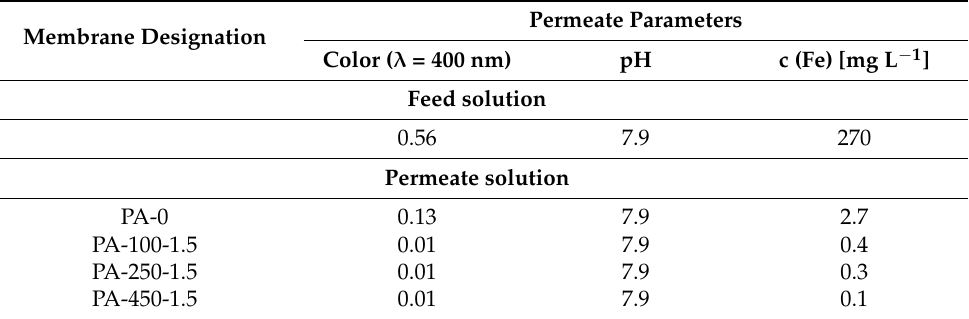
Figure 10. Dependence of 0.005 wt.% HAs solution flux ( a ), fouling recovery ratio (FRR, %) and total flux decline ratio (DT, %) ( b ) on the PAA molecular weight added to coagulation bath. Table 3. Permeate parameters during ultrafiltration of 0.005% HAs solution using devel- oped